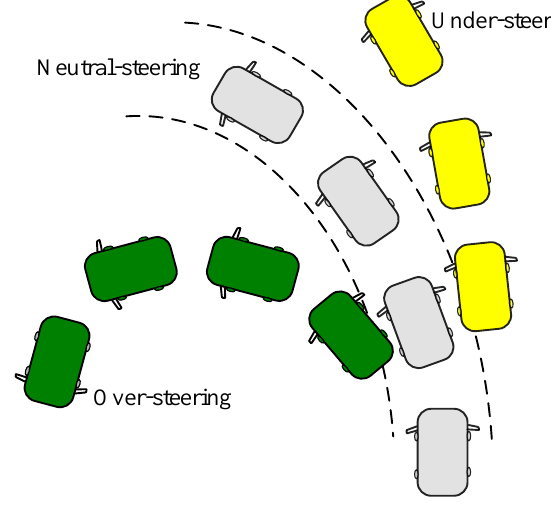
Figure 1. Steering responses while taking a curve.